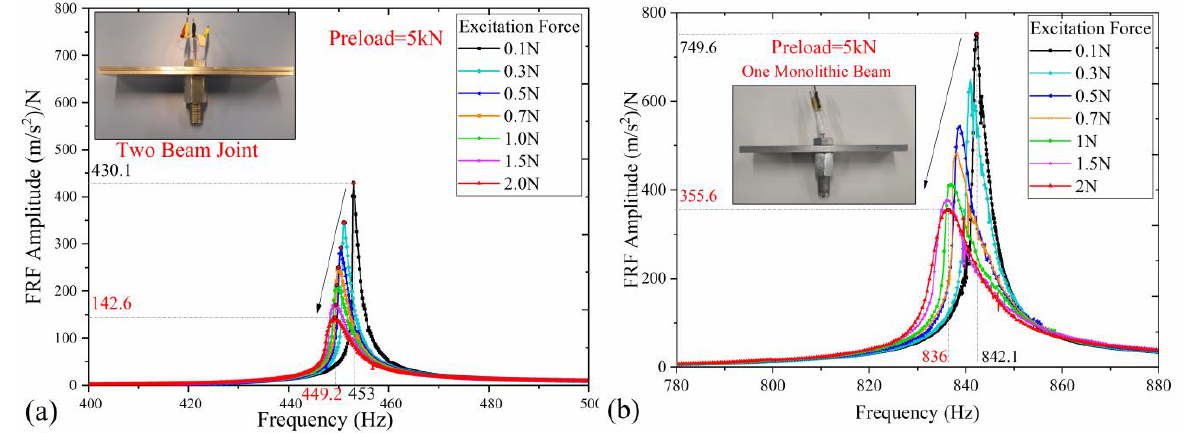
Figure 14. Experimental FRFs influenced by the excitation, ( a ) two-beam joint, ( b ) one monolithic beam.